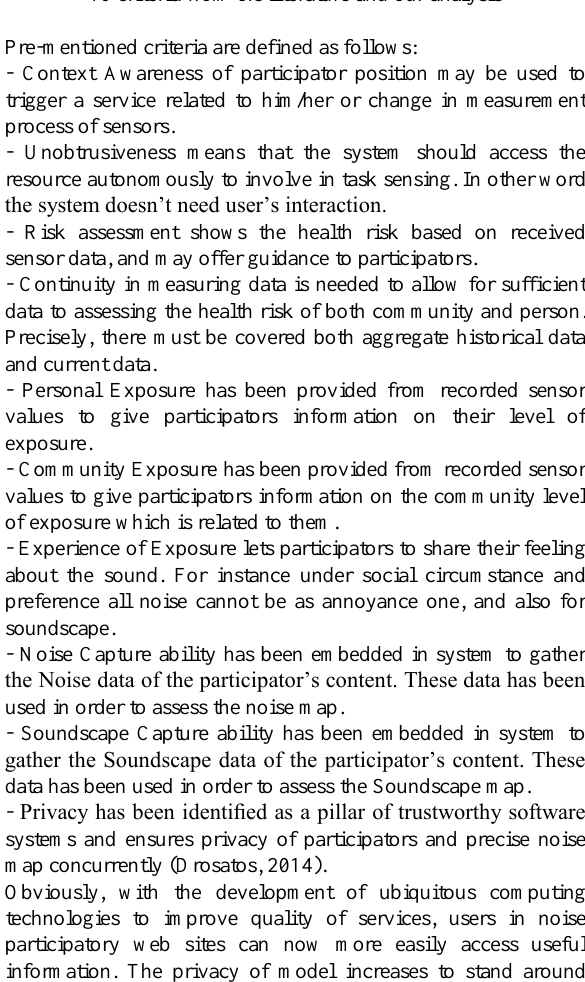
Table 1- A comparison of projects in sound monitoring